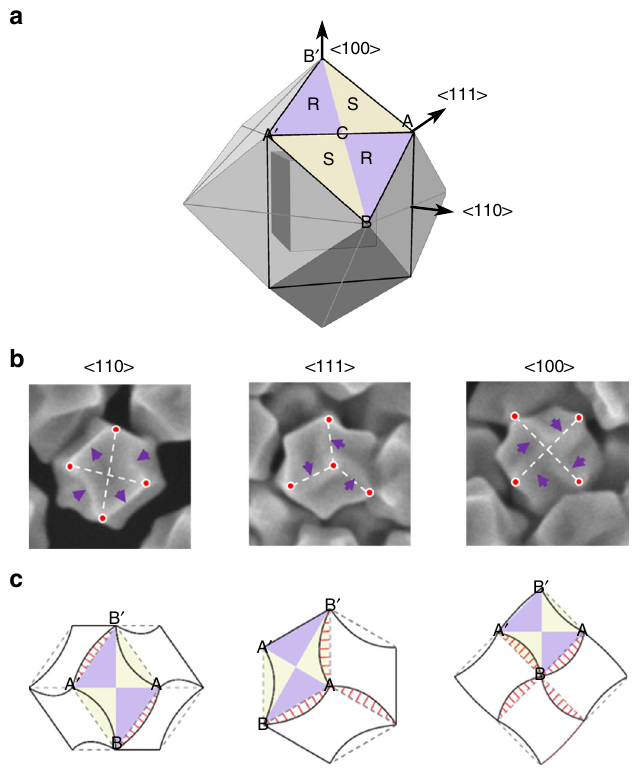
Fig. 2 Mechanism of chiral evolution in 432 helicoid IV. a Overlay of a cube and rhombic dodecahedron (RD) three-dimensional model aligned in the same direction. Crystallographic <110>, <111>, and <100> directions are also shown. Representative rhombus face ABA ′ B ′ is highlighted with a label. Prime ( ′ ) refers to the symmetrical point of the corresponding vertex. In the rhombus, a pair of R and S chiral conformations of a high-index gold surface are illustrated in purple (R region) and yellow (S region). b SEM images of the helicoid oriented along the <110>, <111>, and <100> axes. For clear visualization of the distorted edge, purple arrows and auxiliary white dashed lines that connect the vertices (red dots) are shown. c Two- dimensional schematic model of the RD (dashed gray line) and 432 helicoid IV (solid black line) viewed along three different directions. The same rhombus highlighted in panel a is drawn in all the schematics. The area crossing over the RD outline, the newly expanded R region, is marked with red solid